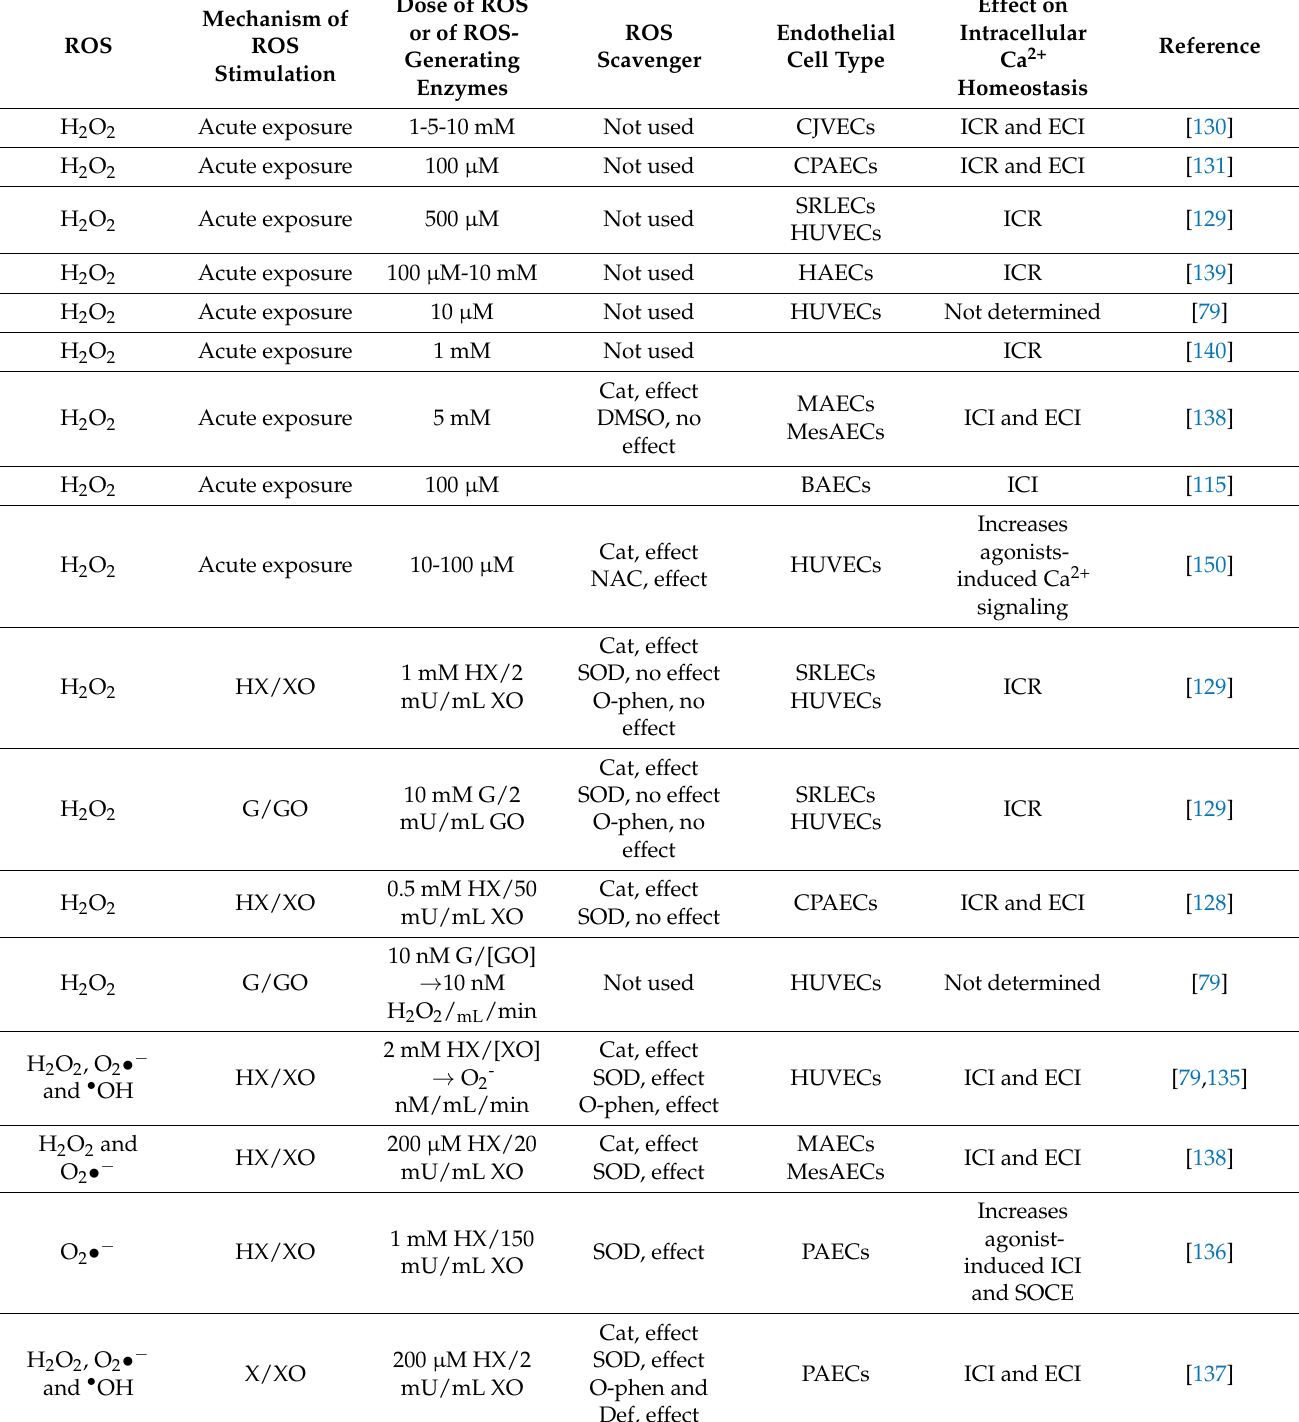
Table 1. Representative studies showing the effect of ROS on endothelial Ca 2+